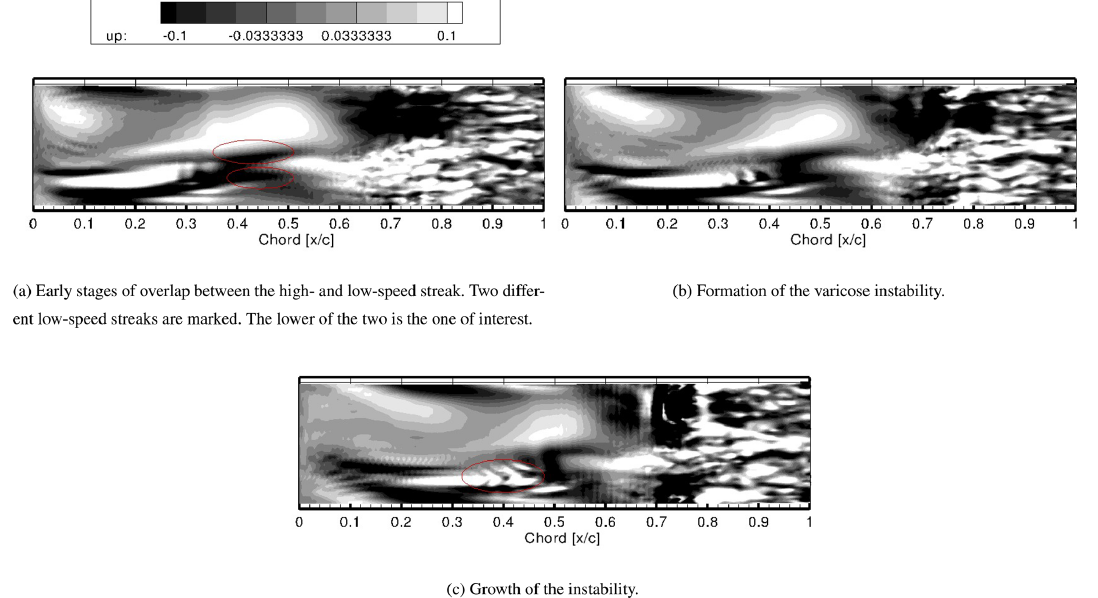
Figure 15. Development of an inner type of instability mode at TI = 2.8%. Contours show the tangential velocity perturbations u (cid:48) . Each im- age in this sequence is taken at a dimensionless time period of 0.1 units apart and at a wall-normal distance corresponding to the displacement thickness at 20% chord.